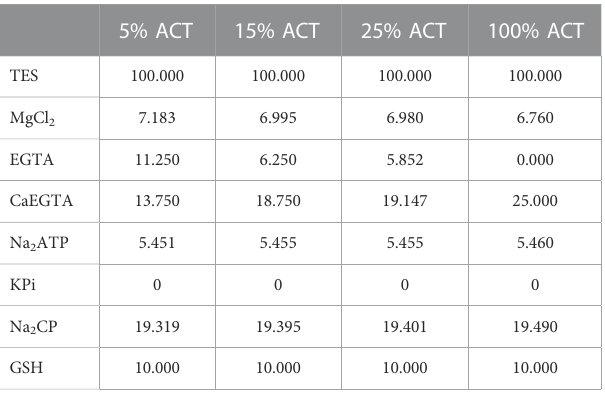
TABLE 1 Recipe of activation solutions used, values are in